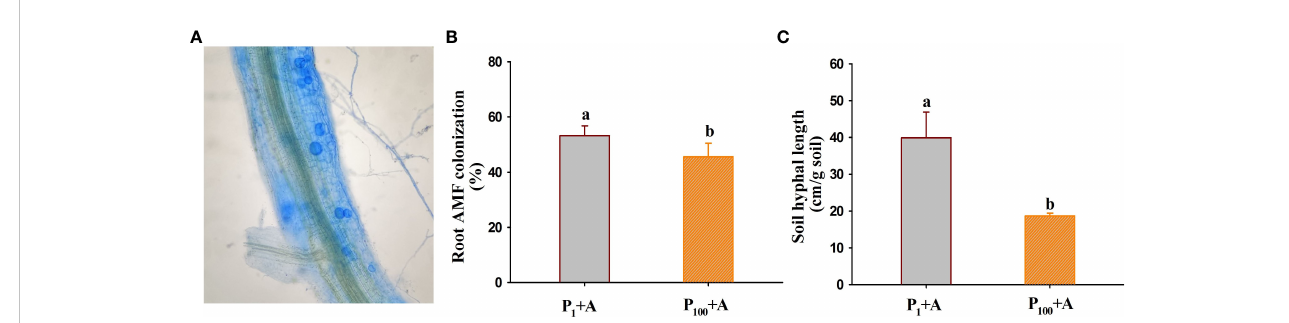
FIGURE 1 Root colonization (A) of Diversispora spurca and changes in root mycorrhizal colonization rate (B) and soil hyphal length (C) of walnut seedlings inoculated with D . spurca grown in 1 and 100 m mol/L phosphorus levels. Data (means ± SD, n = 4) followed by different letters above the bars indicate signi fi cant ( P < 0.05) differences. P 1 +A, the walnut seedlings inoculated with D . spurca at 1 m mol/L phosphorus levels; P 1 -A, the walnut seedlings inoculated without D . spurca at 1 m mol/L phosphorus levels; P 100 +A, the walnut seedlings inoculated with D . spurca at 100 m mol/L phosphorus levels; P 100 -A, the walnut seedlings inoculated without D . spurca at 100 m mol/L phosphorus